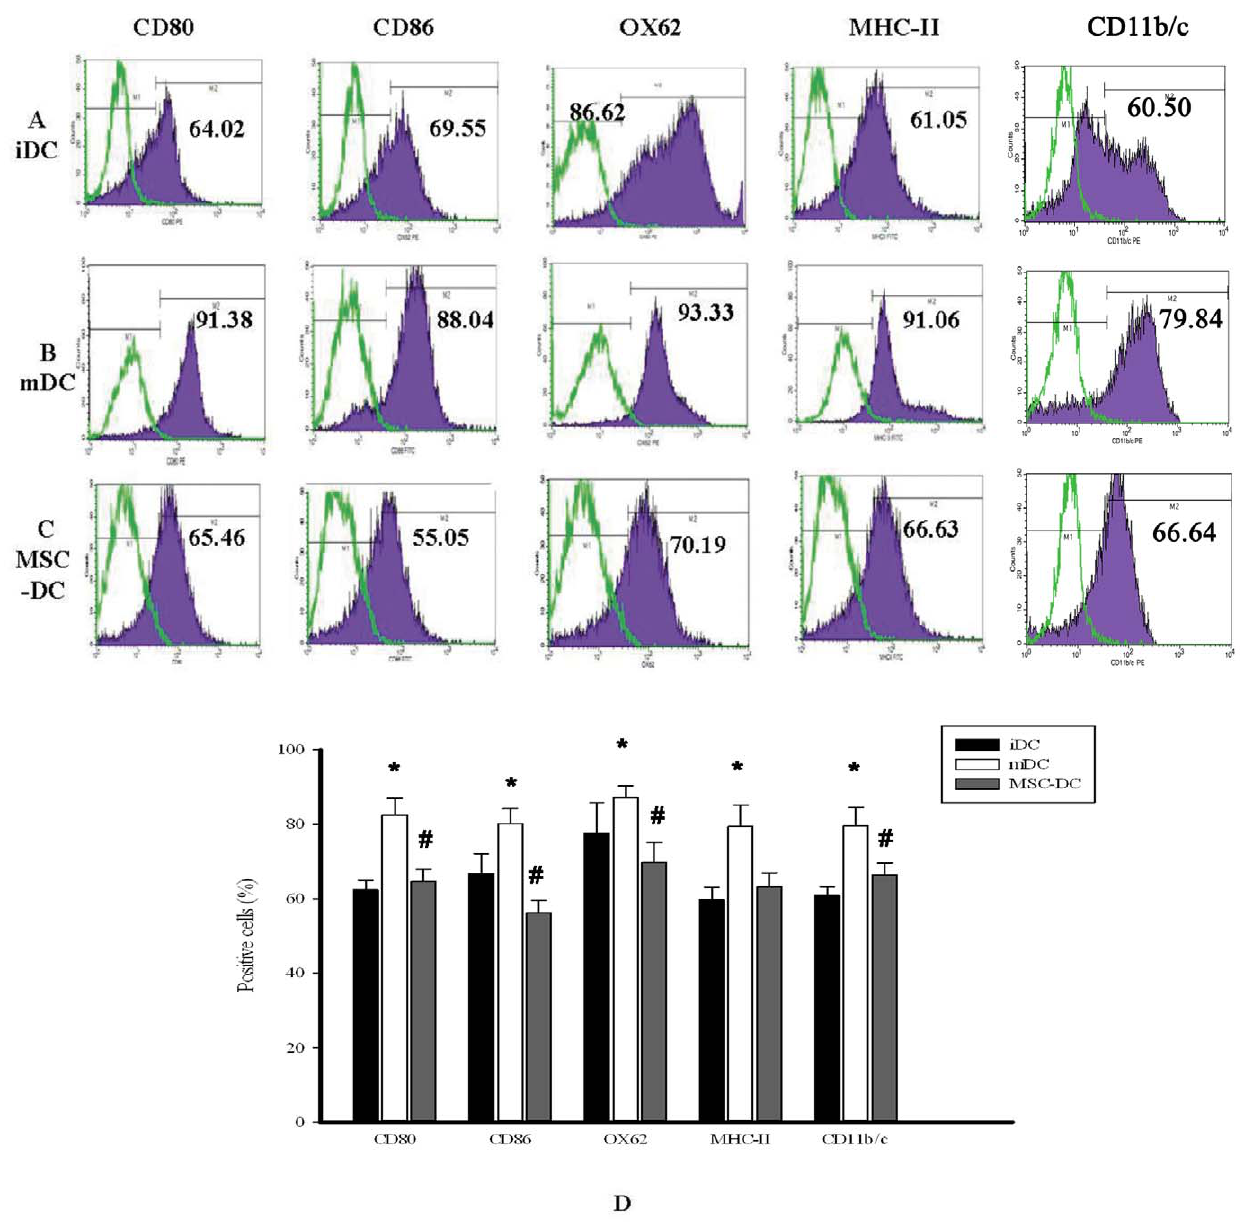
Figure 2. Phenotype analysis of different DCs. (A) FACS histograms showed the expression of cell surface markers on iDCs, which expressed low levels of CD80, MHCII, OX62, CD86 and CD11b/c. OX62 expressed much higher than other makers, because OX62 is an important marker of rat DCs. (B) LPS- stimulated mature DCs (mDCs) showed about equally up-regulated levels of all markers. Except CD86, three makers showed above 90 percent expression. (C) MSC-DC-LPS-activated DCs in co-culture expressed lower levels of the four markers compared with mDCs, but the expression was slightly higher when compared with iDCs. This result suggests that MSCs inhibit DCs phenotype expression (MSC:DC=1:10). Data represent mean fluorescence intensity for the surface density of markers. (D) Quantification by image analysis of the positive cells. The numbers in the histograms indicate the mean fluorescence of each DCs markers. *P , 0.05(mDC group versus iDC group), # P , 0.05(MSC-DC group versus mDC